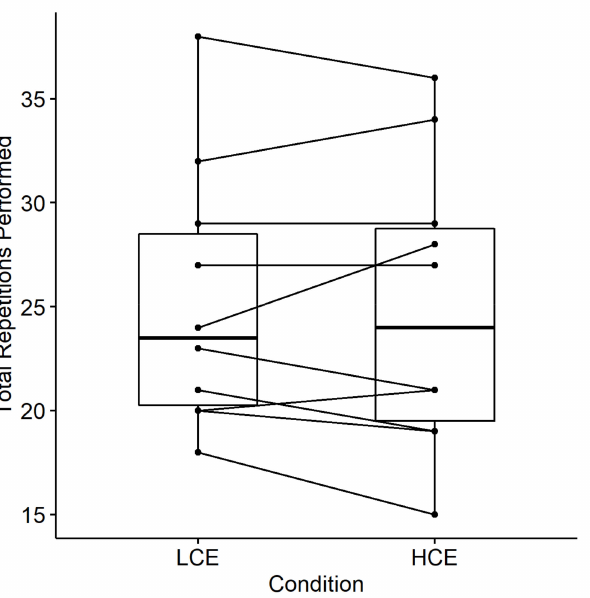
Figure 3. Individual data points and box-and-whisker plots (minimum, median, interquartile range and maximum) for total repetitions performed, by condition. LCE = low cognitive exertion; HCE = high cognitive